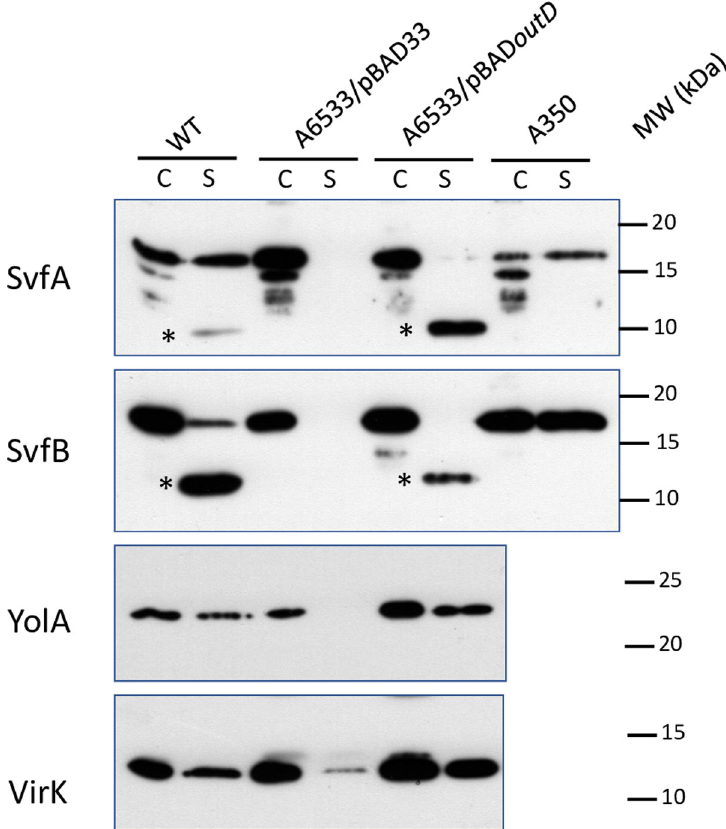
Fig 1. Identification of new secreted proteins by D . dadantii . Wild-type, A6533 outD mutant complemented or not by outD and strain A350 containing plasmid bearing the gene of the protein to test were grown overnight in LB medium. 15 μ l of supernatant (S) and cellular (C) fractions were separated by SDS-PAGE. After blotting, the proteins were detected with anti-6His antibody. � indicates the processed form of SvfA and SvfB.